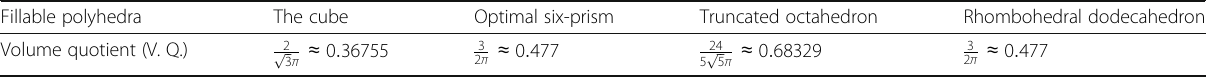
Table 2 Volumetric comparison of fillable polyhedra Fillable polyhedra The cube Optimal six-prism Truncated octahedron Rhombohedral dodecahedron Volume quotient (V.